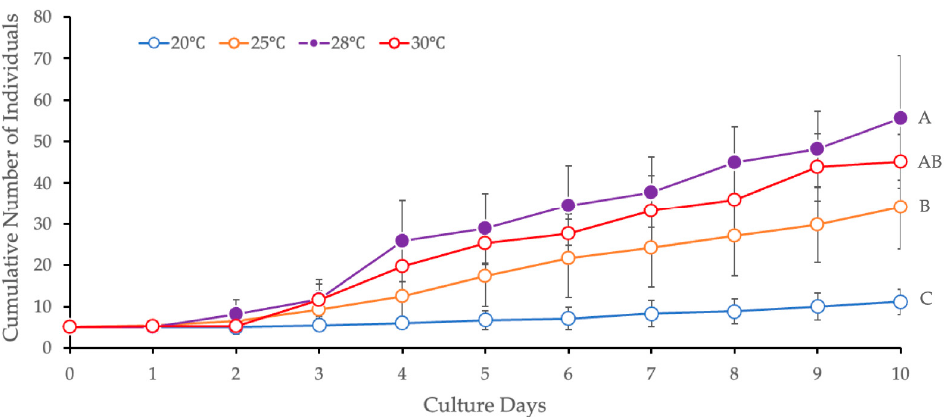
Figure 6. Population growth of A. minuta at different temperatures over a 10-day culture period. Data are expressed as means ± SD; each of the temperature treatments started with five anemones at day 0. Letters beside the 10th day of the dotted line graph denote significant differences in relation to different temperature treatments ( p < 0.05, n = 5–19, A > B > C). Table 4. Statistical comparisons of the effect of temperature, diet, and salinity conditions on the population growth of sea anemone A. minuta during the 10–14-day culture period. Treatments with a p -value < 0.05 were considered significant and highlighted in bold and with an asterisk “*”. Experiment Groups Compared p -Value Statistical Test